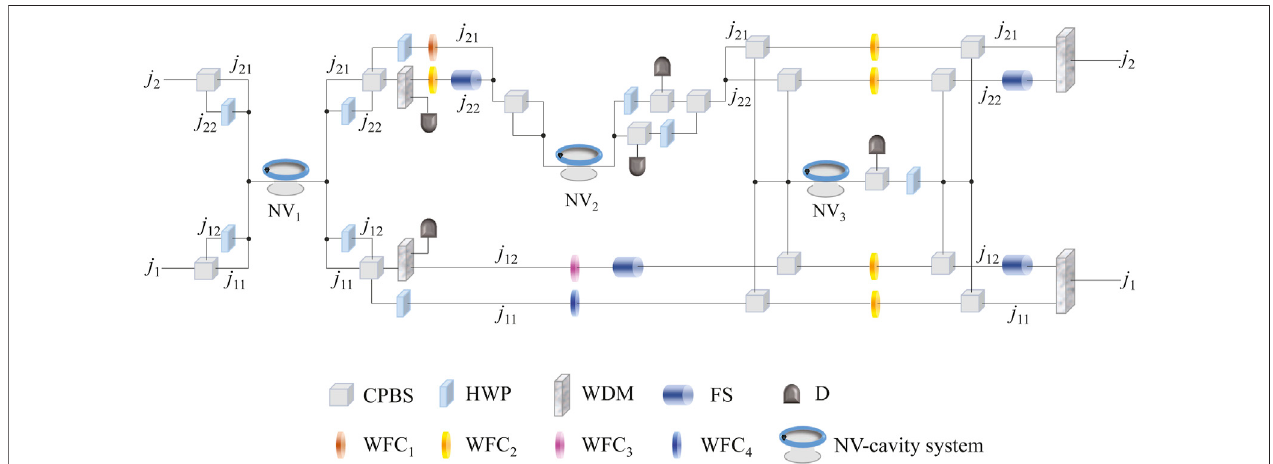
FIGURE 2 | Schematic diagram for implementing the high- fi delity photonic three-DOF hyperparallel CPF gate. j 1 and j 2 , where j = a , b , are the input ports for the controlphoton a andthetargetphoton b beinginjectedtothecircuitinsequence.CPBSrepresentsacircularlypolarizingbeamsplitterinthebasis{| F 〉 ,| S 〉 }transmitting the | F 〉 -polarized photon and re fl ecting the | S 〉 -polarized photon. HWP is a half-wave plate set at 0 ° performing operation | F 〉 ↔ | S 〉 . WFC i ( i = 1, 2, 3, 4) represent wave- form corrector introducing coef fi cients r a frequency shifter which can shift the frequency ω 1 to ω 2 . D is a single-photon